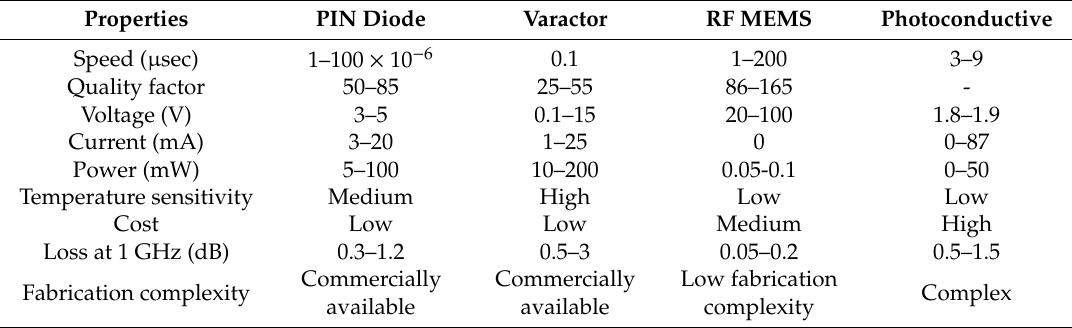
Table 6. Comparison between switching techniques